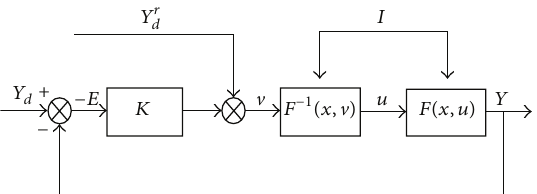
Figure 4: The diagram of dynamic inversion control